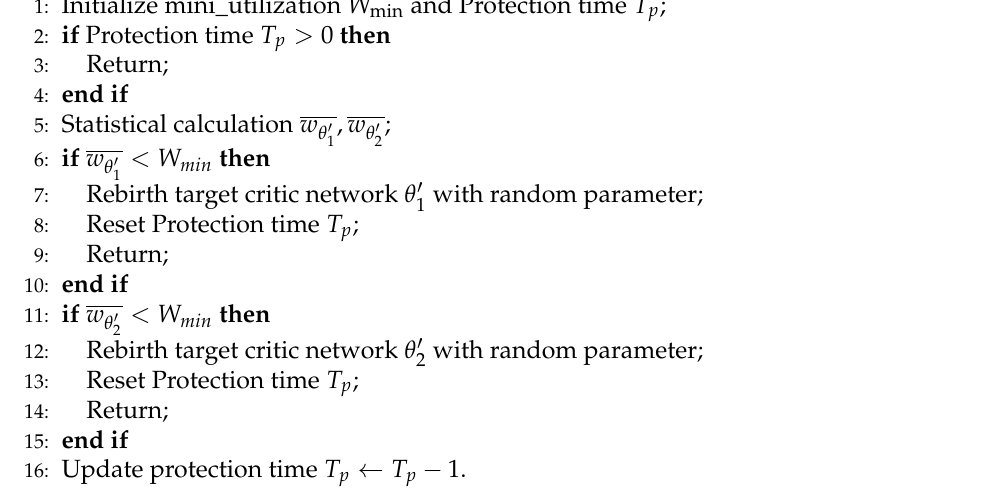
Figure 4. Mechanism of rebirth. Algorithm 2 Algorithm Rebirth Target